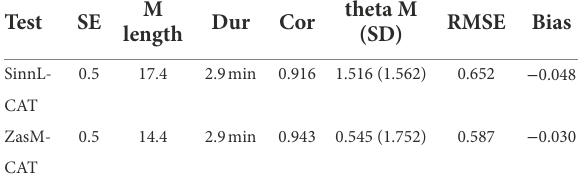
TABLE 5 Results of CAT simulations of fixed length and fixed SE stopping rules with 1,000 test executions each and the resulting test lengths in items and minutes, the correlation between estimated θ - and actual θ - as well as RMSE- and bias